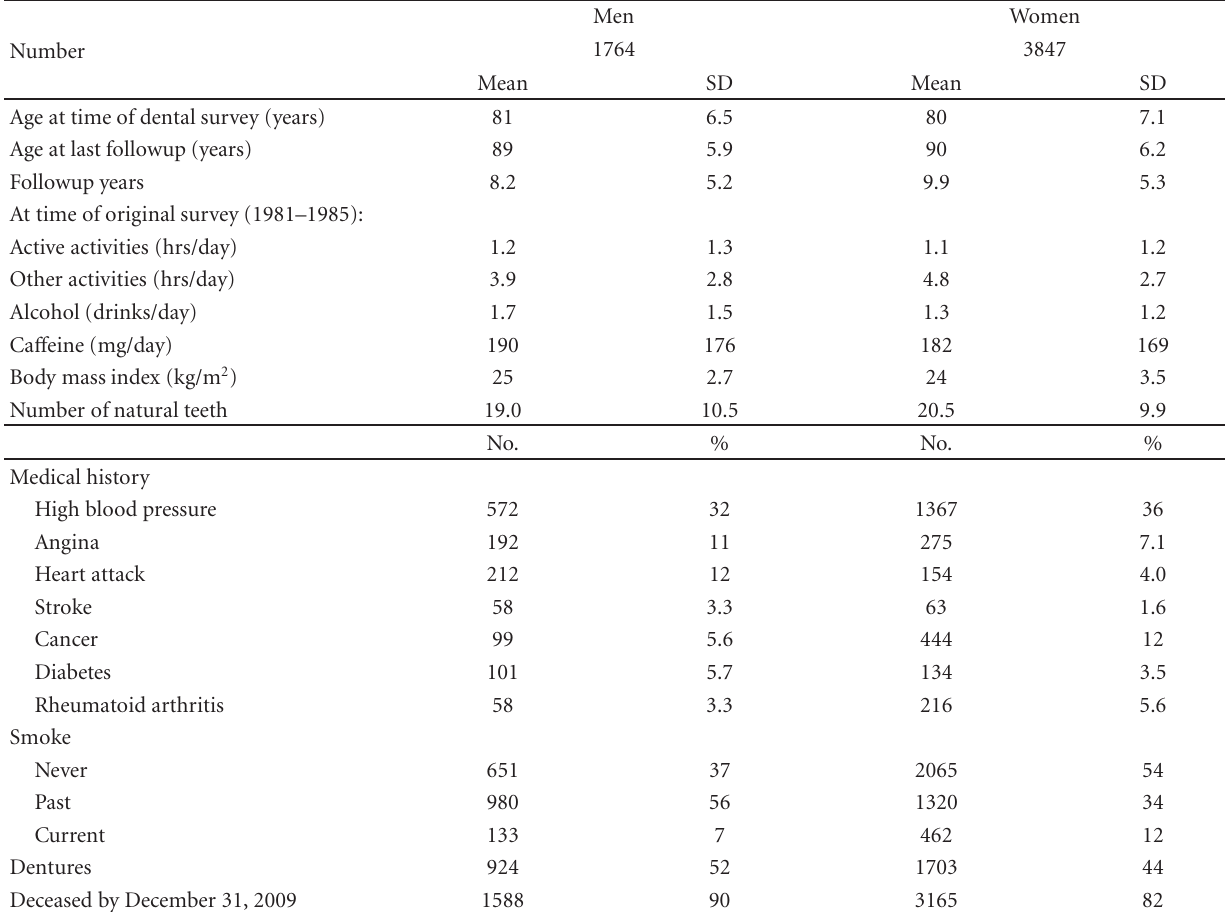
Table 1: Characteristics of the cohort by